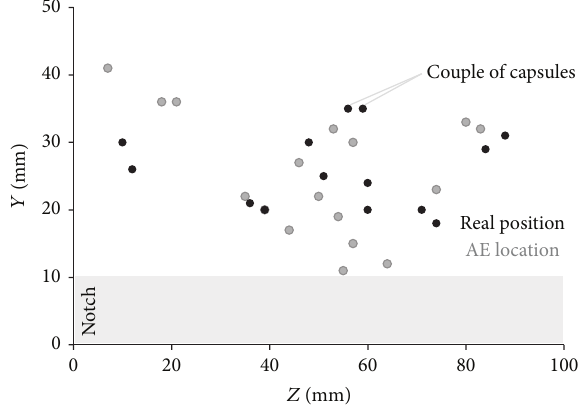
Figure 12: Real and AE located capsule breakage position at the crack plane.